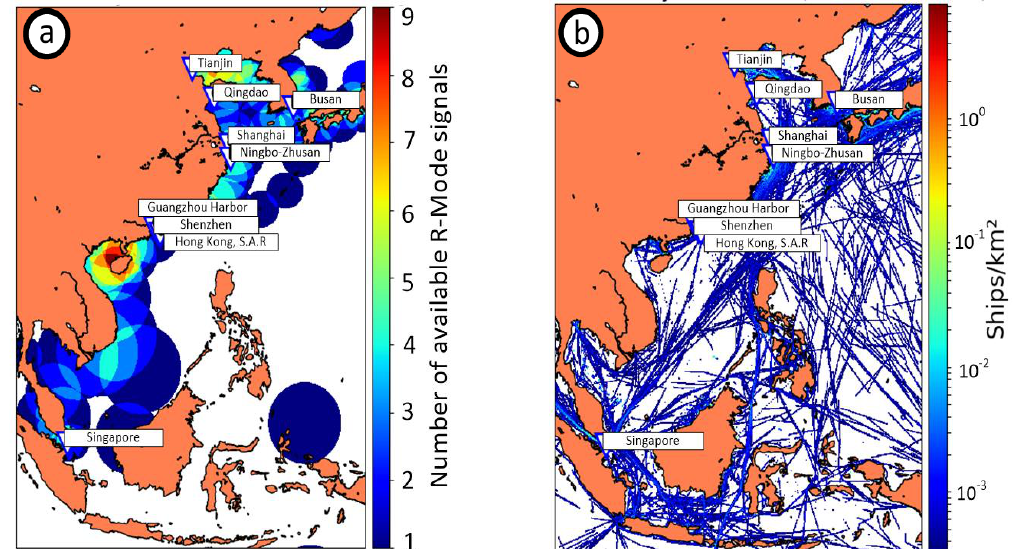
Figure 10. Comparison of location of the top nine container ports in respect to R-Mode coverage ( a ) and traffic density ( b ).